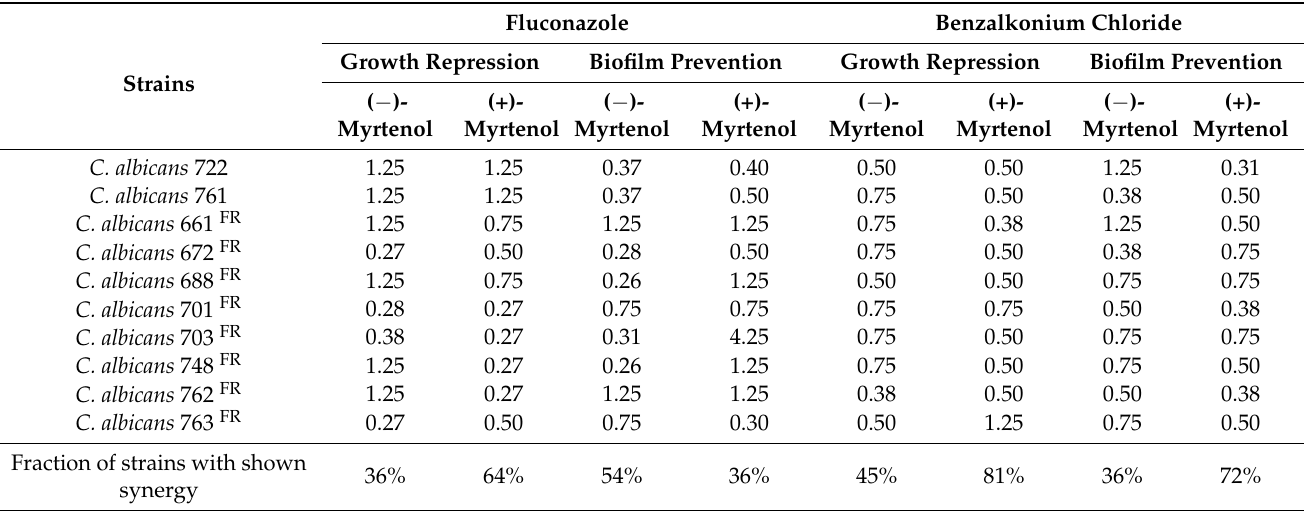
Table 4. FICI values of fluconazole and benzalkonium chloride in combination with either ( −